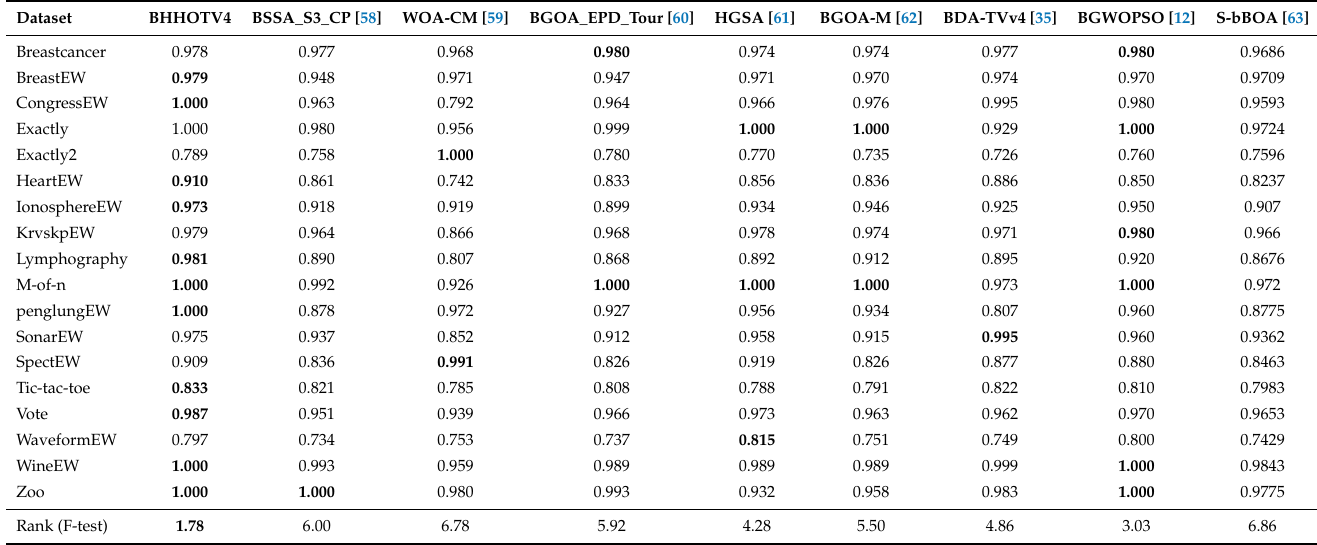
Table 13. Comparison of the proposed BHHO TV 4 and other approaches from previous works in terms of accuracy rates.